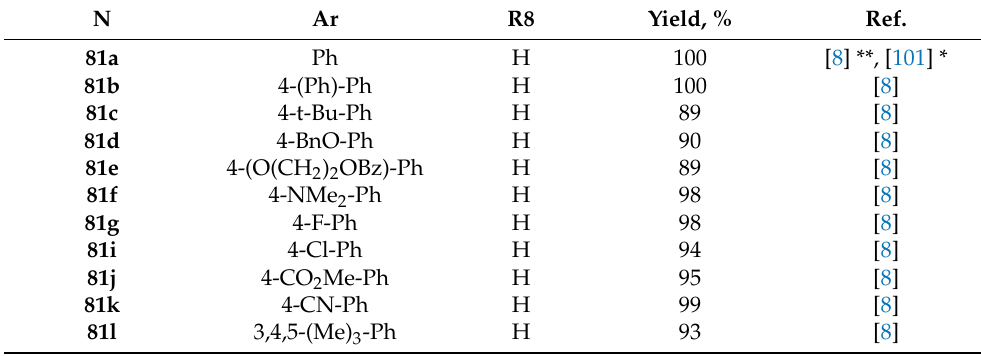
Table 21. Substituents and yields of the ring closure reaction on Scheme